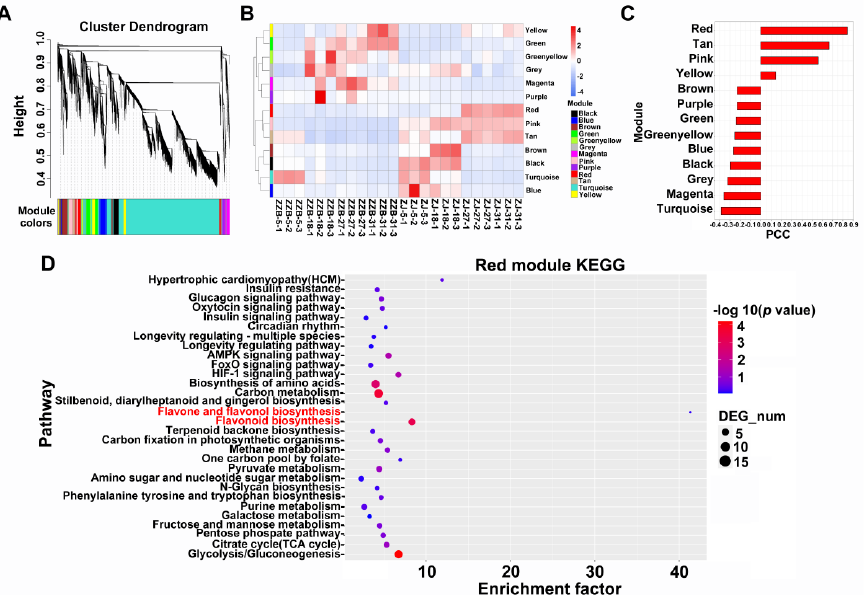
Figure 3. WGCNA analysis of transcripts in ZJ and ZZB genotypes during fruit development. ( A ) Hierarchical clustering tree. ( B ) Module eigengene expression. ( C ) Pearson correlation coefficient, PCC ( r ) between the red module and anthocyanin content in ZJ and ZZB at different post-flowering stages. ( D ) KEGG enrichment analysis of the red module.